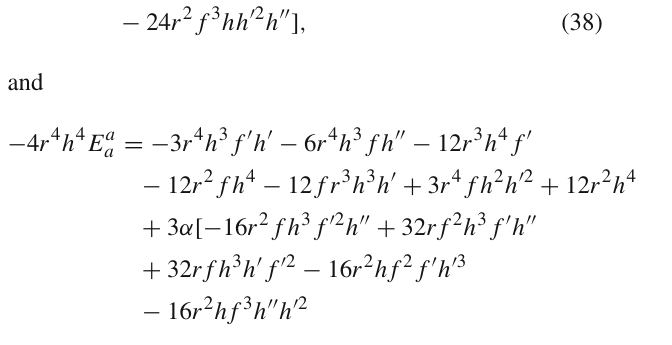
Fig. 6 The temperature, entropy and mass as a function of r + for c 1 = − 0 . 25 ,α = 0 . 5: solid lines are the results of our method and dashed lines are the results of the paper [17,18]. For α = − 0 . 5: Long dashed lines are the results of our method and dotted lines are for the paper [17,18] − 24 r 2 f 3 hh (cid:4) 2 h (cid:4)(cid:4) ] , (38) and = − 3 r 4 h 3 f (cid:4) h (cid:4) − 6 r 4 h 3 f h (cid:4)(cid:4) − 12 r 3 h 4 f (cid:4) − 4 r 4 h 4 E a a − 12 r 2 f h 4 − 12 f r 3 h 3 h (cid:4) + 3 r 4 f h 2 h (cid:4) 2 + 12 r 2 h